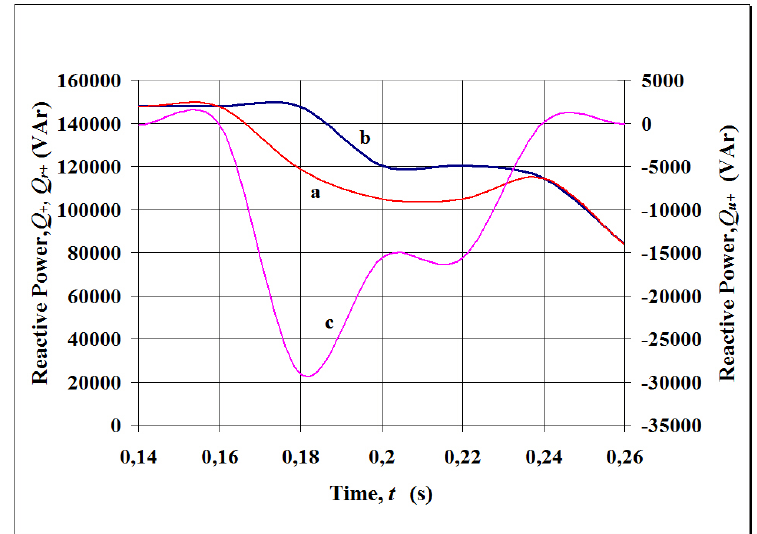
Figure 11. Positive-sequence reactive powers: ( a ) total, ( b ) due to reactive loads, ( c ) caused by